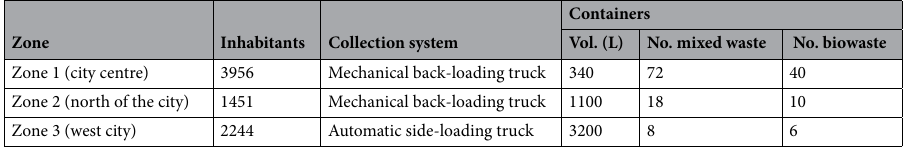
Table 1. Characteristics of the study areas.